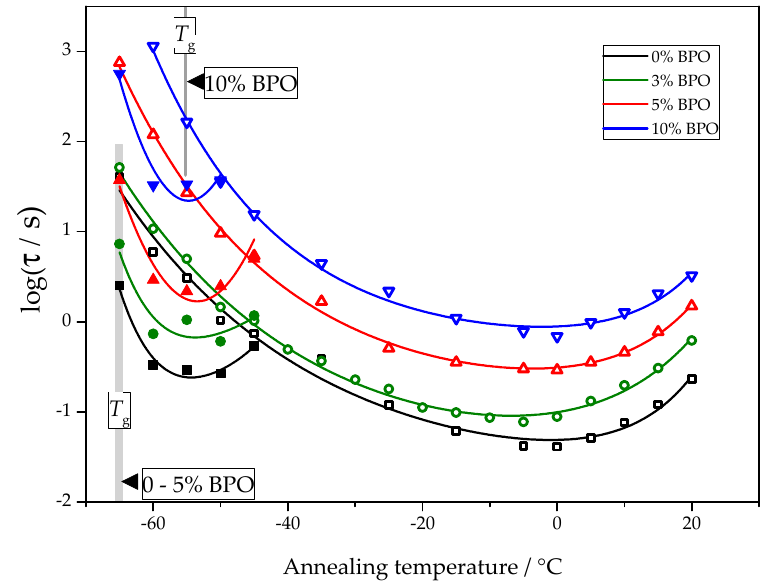
Figure 6. The crystallization halftime (hollow symbols) and nucleation halftime (solid symbols) as a function of the annealing temperature for PCL samples with different cross-link densities.